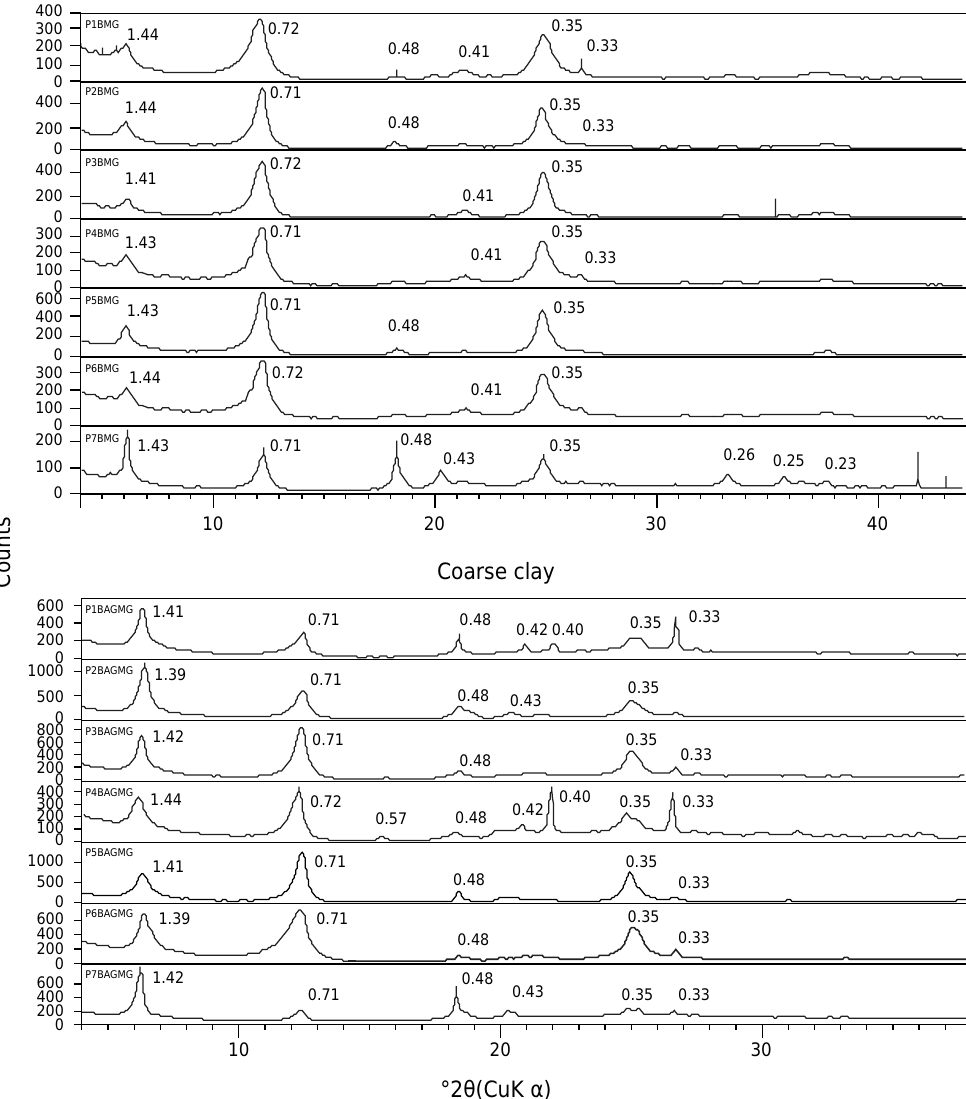
Figure 1. X-ray diffractograms of the total clay and coarse clay fraction samples from the B horizon, saturated with magnesium and read at ambient temperature in the seven soil profiles studied. Spacing values in nanometers